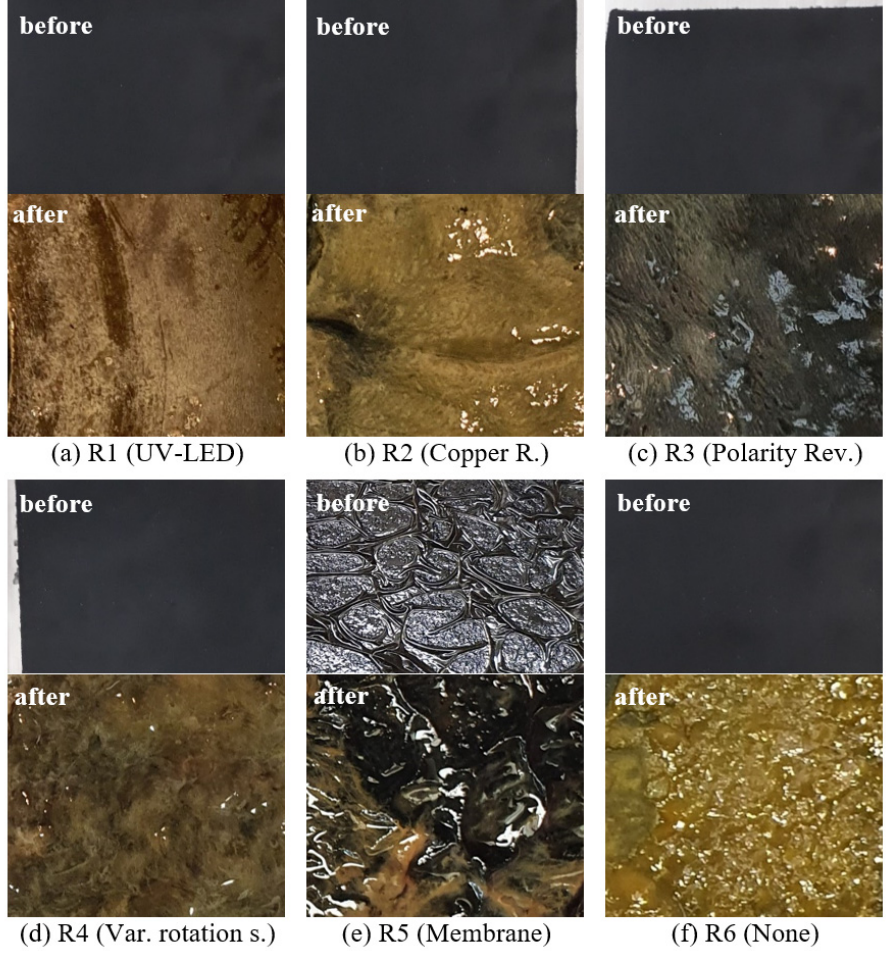
Figure 5. Photos of biofilms on GDEs after disassembling.